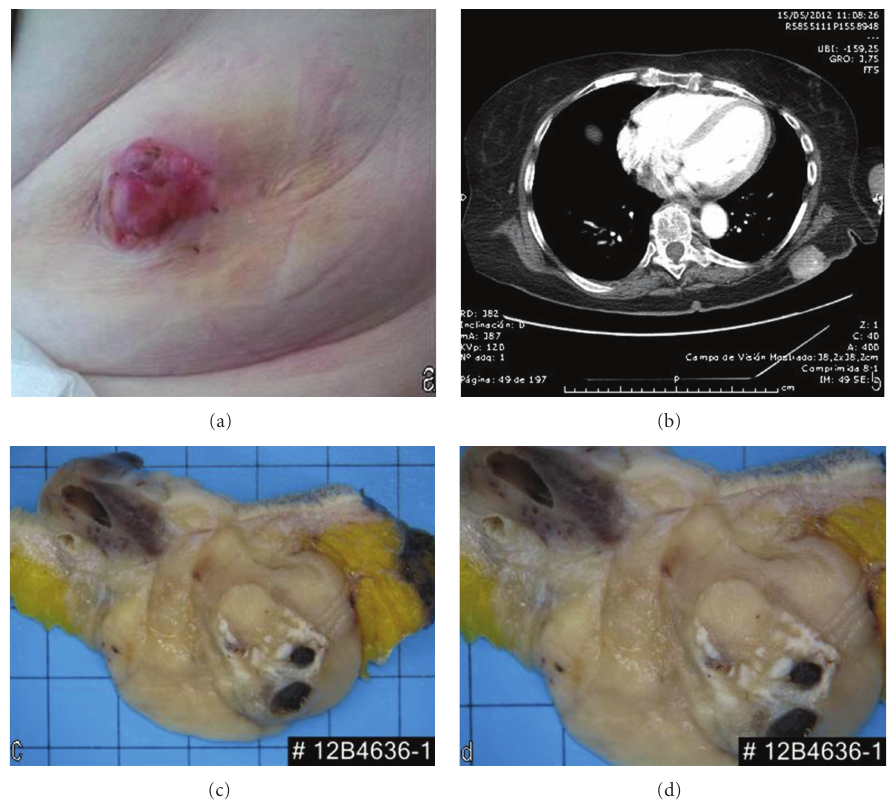
Figure 1: (a) Skin lesion showing an irregular lobular shape pink tumor. (b) Cranial tomography showing a tumoral lesion in the left skin region. Isolated calcifications are present. (c), (d) Surgical resection showing a solid multinodular calcified tumoral lesion, (note that no relation with skin is